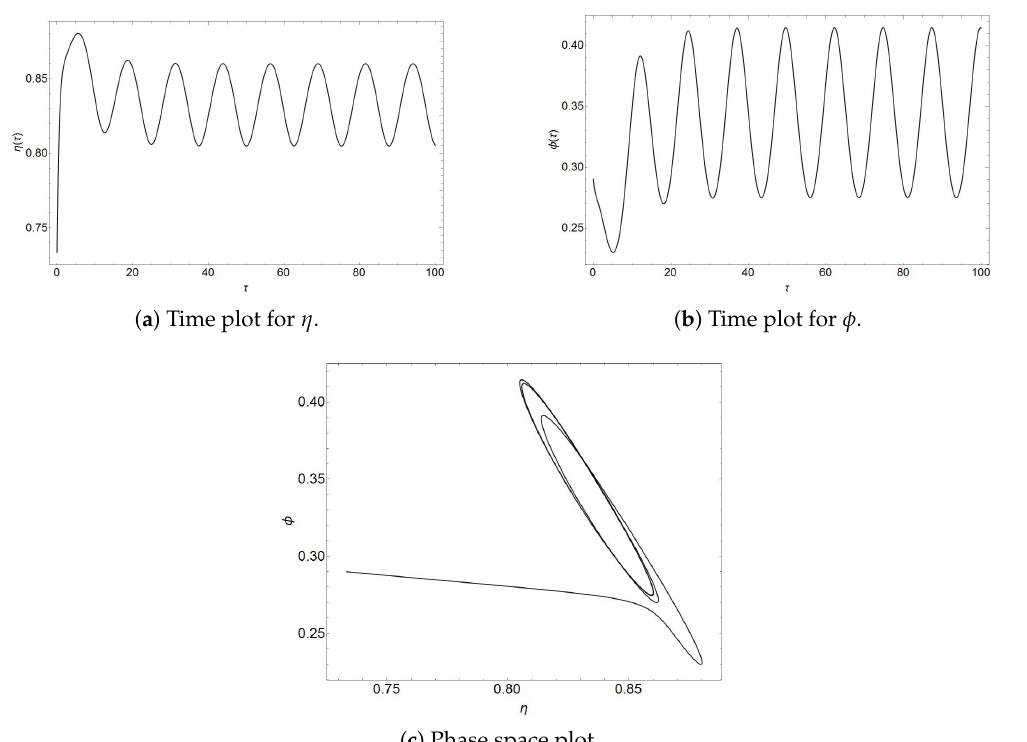
( c ) Phase space plot. Figure 5. Plots for the Q-Switching technique with initial conditions η ( 0 ) = 0.73 and φ ( 0 ) =